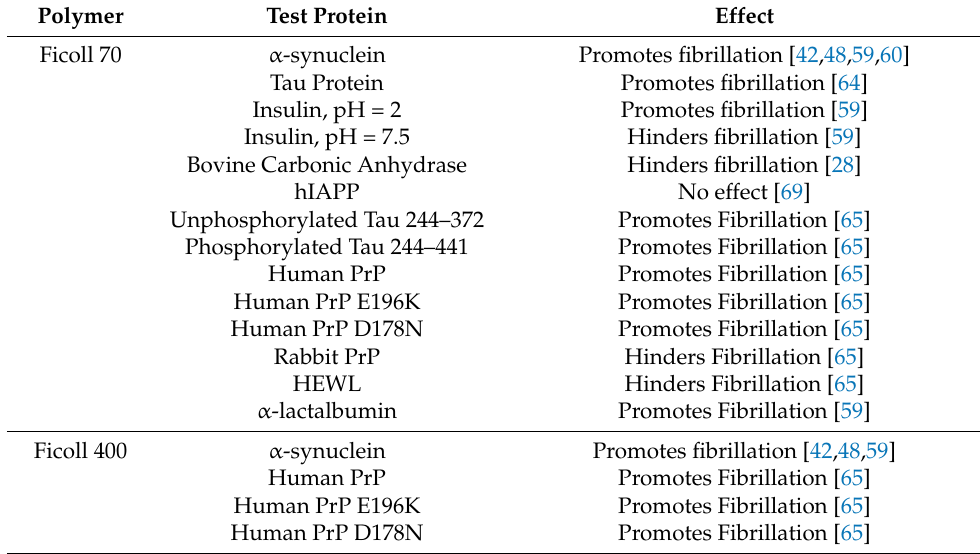
Table 1. Effects of synthetic polymers on protein